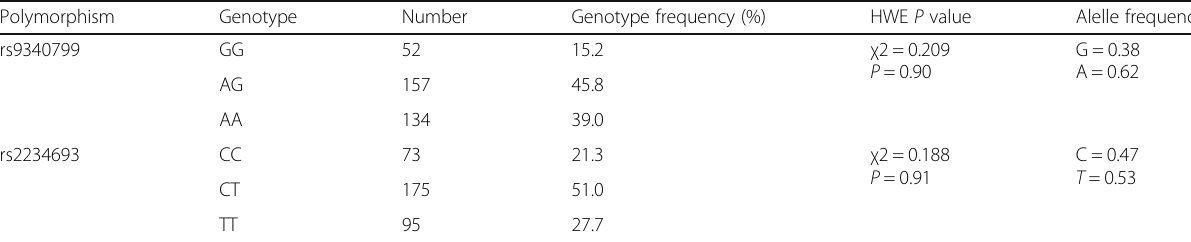
HWE Hardy-Weinberg equilibrium (the chi-square test value)